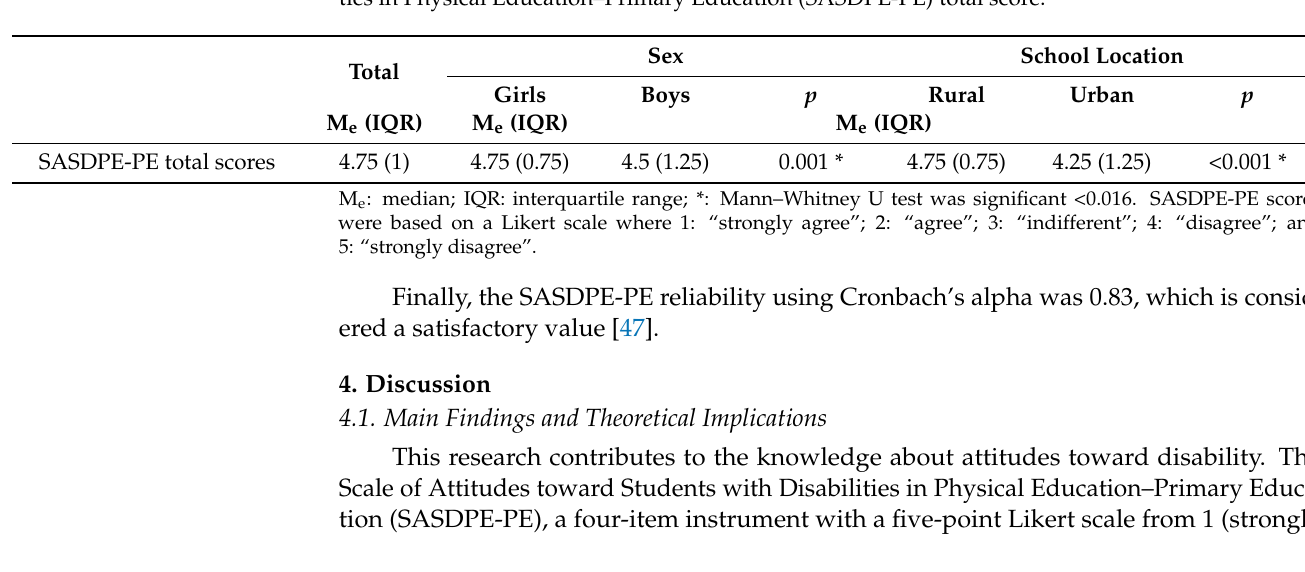
Table 4. Descriptive analysis and differences for the Scale of Attitudes toward Students with Disabili- ties in Physical Education–Primary Education (SASDPE-PE) total